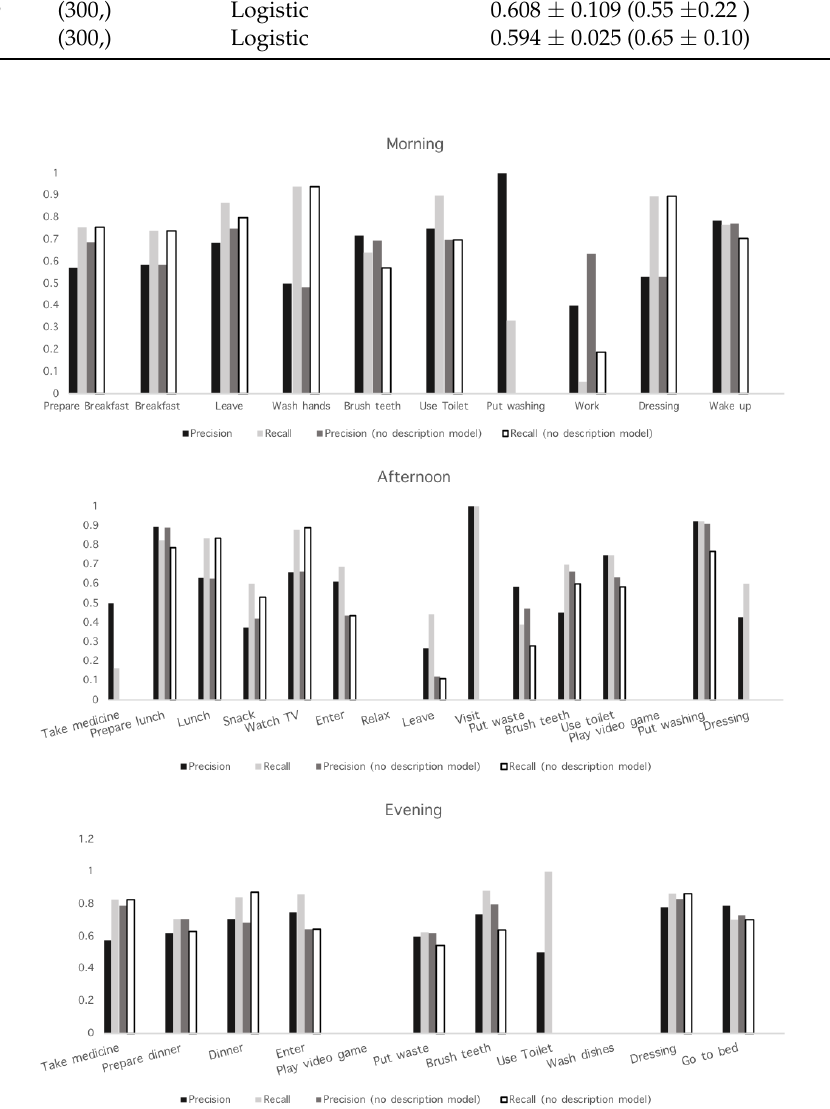
Figure 1. Precision and Recall for each activity using the morning, afternoon and evening models. The test data had 6 days and 545 time windows. The accuracy obtained in the cup was 45.0% which is lower than expected. The results for each activity are shown in Figure 2. The recall for Relax was low, only one instance was predicted as being from this class. This lowered the overall accuracy. Other activity with low recall is Work . This activity also had low recall in the training process so it was